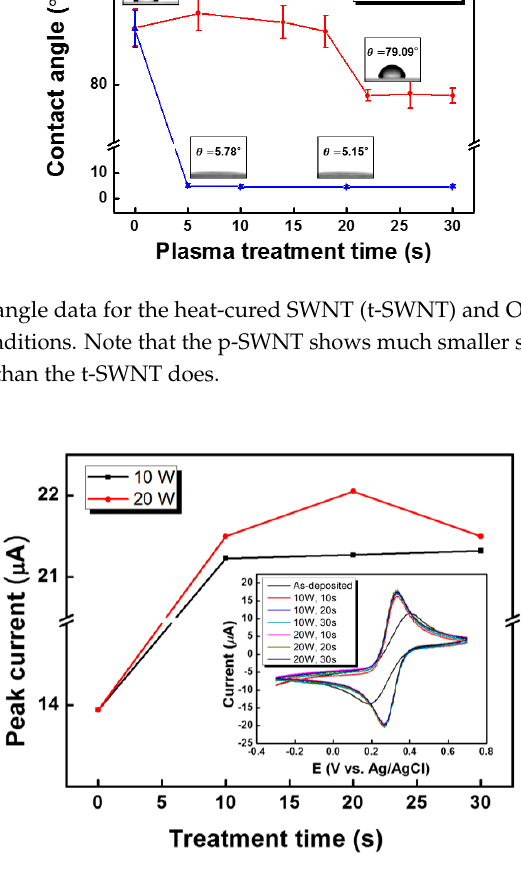
Figure 3. Peak current (i p ) of the p-SWNT at various conditions. Detailed experimental conditions for the cyclic voltammograms are as follows: redox species = 10 mM K 3 [Fe(CN) 6 ], electrolyte = 3 M KCl solution, and scan rate = 100 mV ∙ s − 1 .